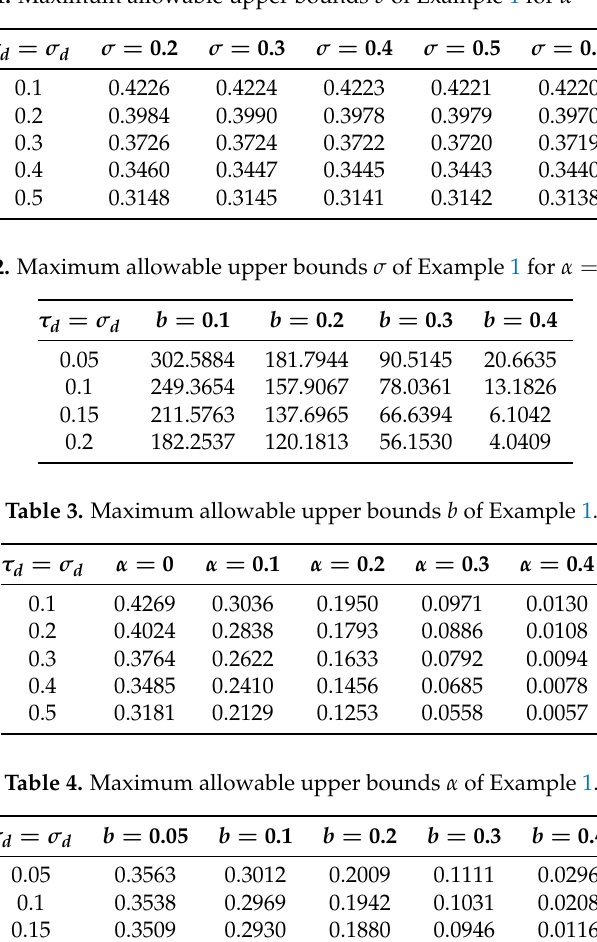
Table 1. Maximum allowable upper bounds b of Example 1 for α = 0.0038.